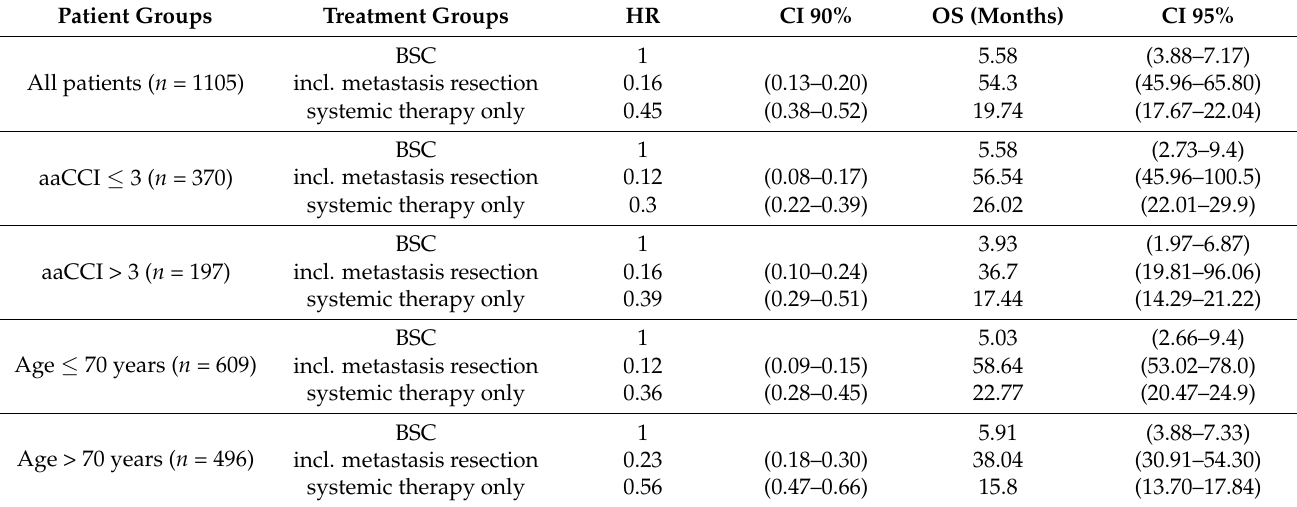
Table 2. Clinical outcome in all patients and subgroups defined by comorbidities and age depending on treatment. Patient